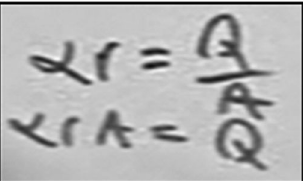
FIG. 6. Equations set up by students in the conventional